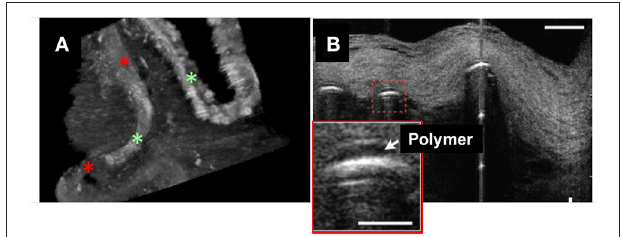
FIGURE 2 | 3D- µ OCT of stent and endothelial coverage morphology in the human cadaver coronary artery ex vivo. (A) 3D- µ OCT image of a drug-eluting stent (DES) implanted in a human coronary artery, showing tissue coverage with low intensity signal (red asterisks) and the surface of polymer coating as highly reflective regions (green asterisks). Scale bars, 100 µ m. Unpublished data, obtained at the Massachusetts General Hospital. (B) DES struts showing polymers (red dashed box and inset) overlying the stent strut reflections. Scale bars, 30 µ m. Figure and capture reprinted with permission from Liu et al.